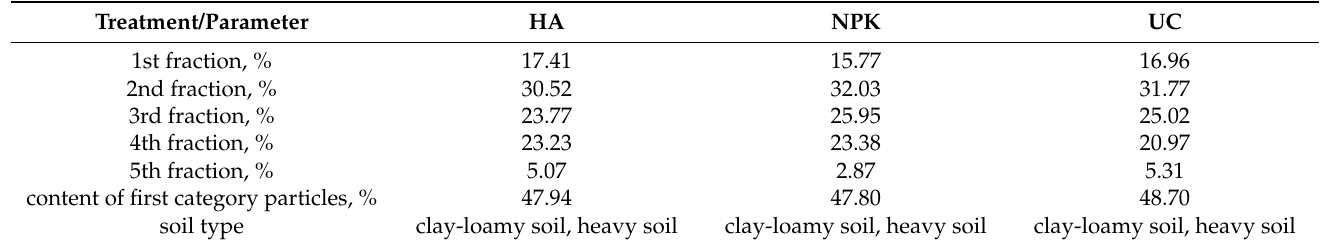
Table 1. Soil type based on clay content in topsoil layers (0–30 cm).